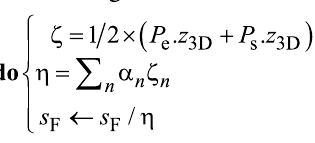
For the set of values {( h i +1 − h i )/( z 3D, i +1 − z 3D, i )} vs the